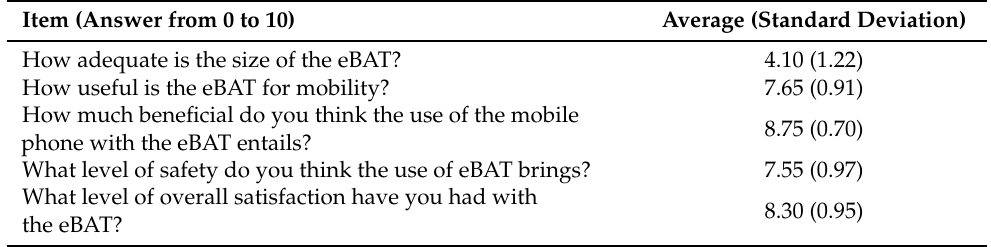
Table 4. Average and standard deviations for answers to the questions in the satisfaction